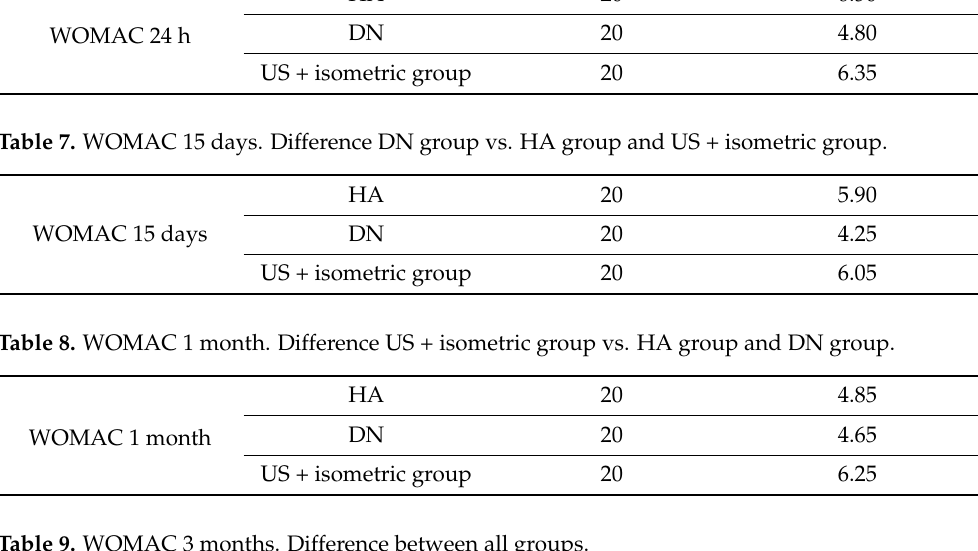
Table 9. WOMAC 3 months. Difference between all